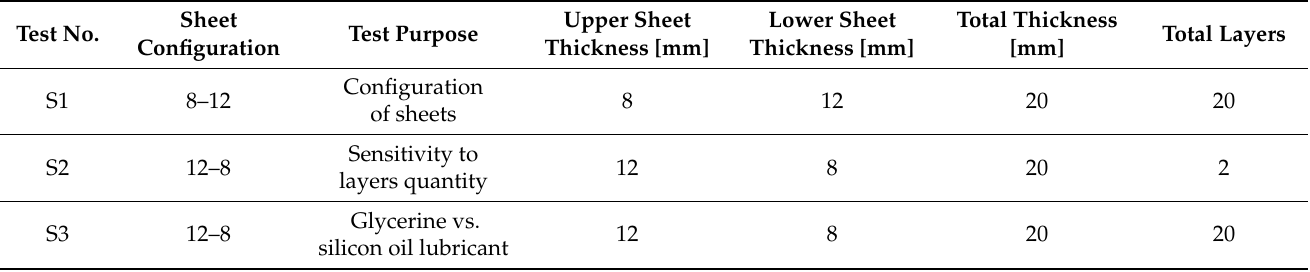
Table 1. Different configurations of plasticine slab used in an analogue modelling experiment. Test